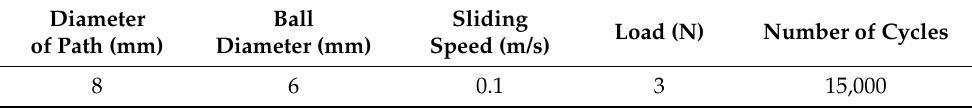
Table 3. Parameters of ball on disk